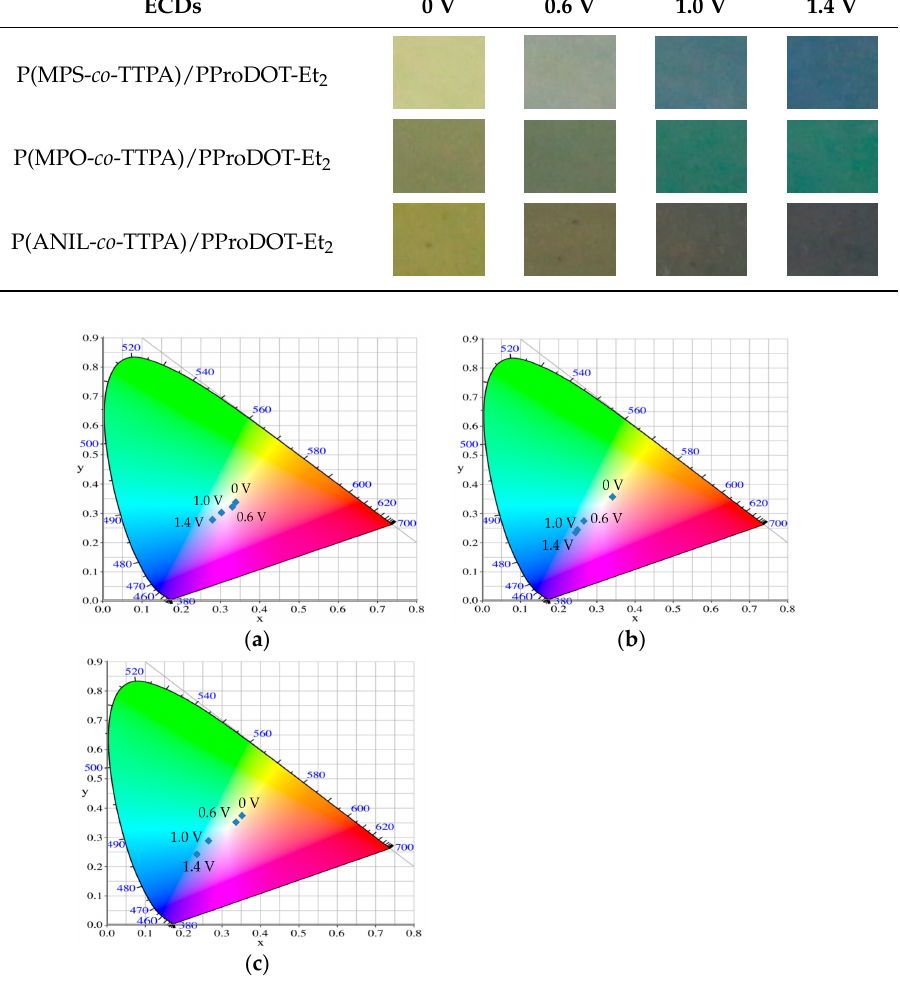
Figure 9. CIE chromaticity diagrams of ( a ) P(MPS- co -TTPA)/PProDOT-Et 2 ; ( b ) P(MPO- co - TTPA)/PProDOT-Et 2 ; and ( c ) P(ANIL- co -TTPA)/PProDOT-Et 2 ECDs. Table 6. Color–bleach switching properties of